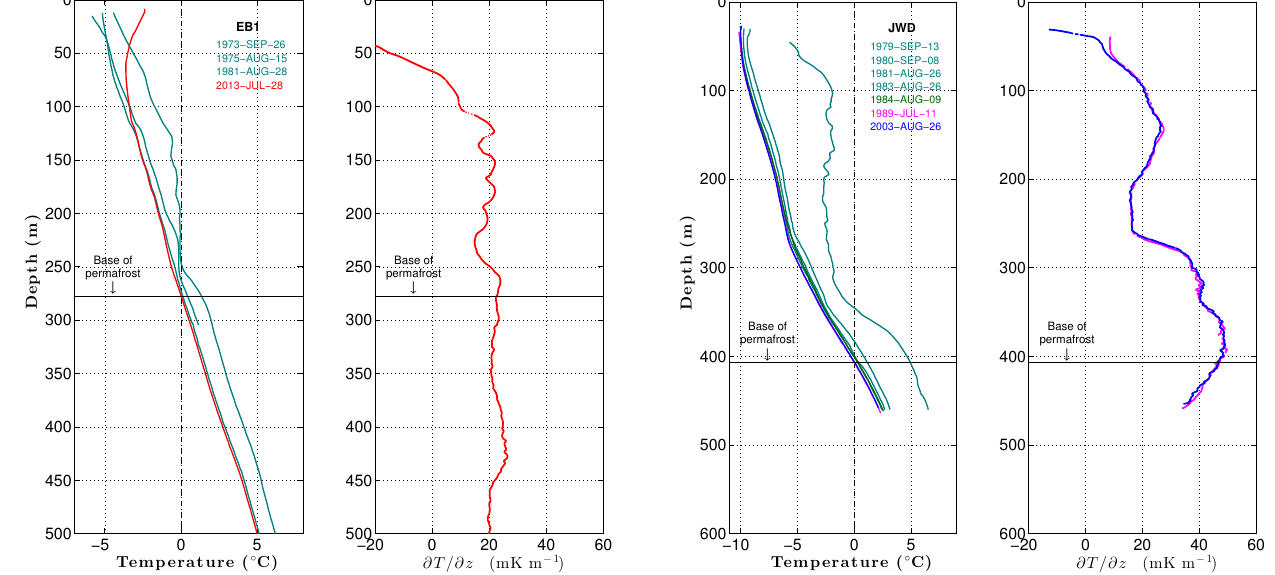
www.earth-syst-sci-data.net Earth Syst. Sci. Data